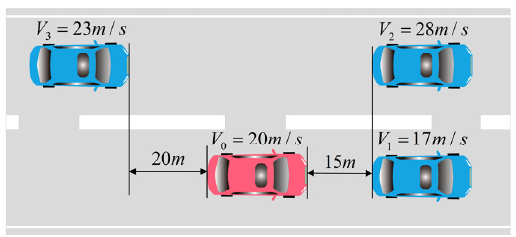
Figure 9. Traffic environment in MIL.